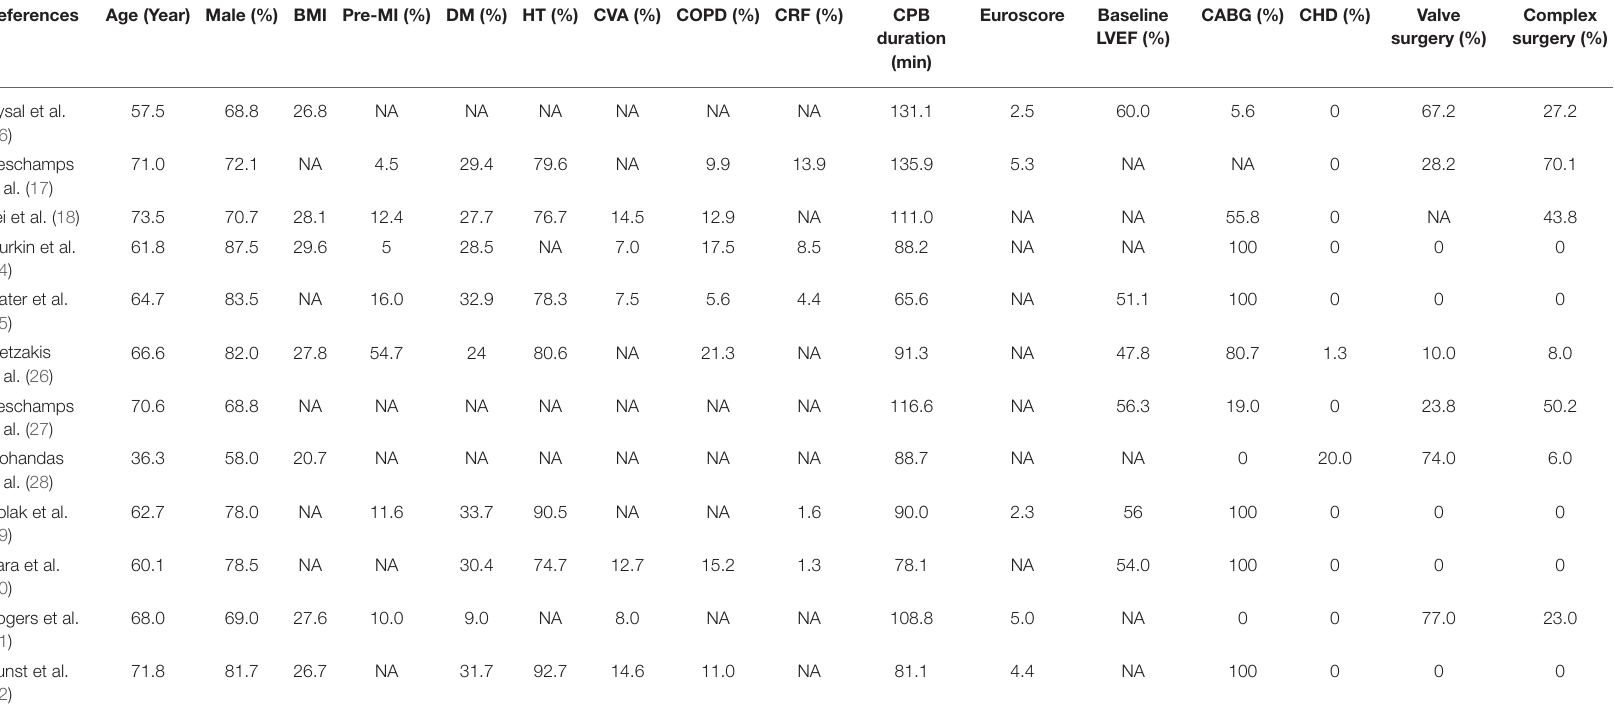
TABLE 2 | Baseline characteristics, medical conditions, and perioperative data of included studies for meta-analysis.